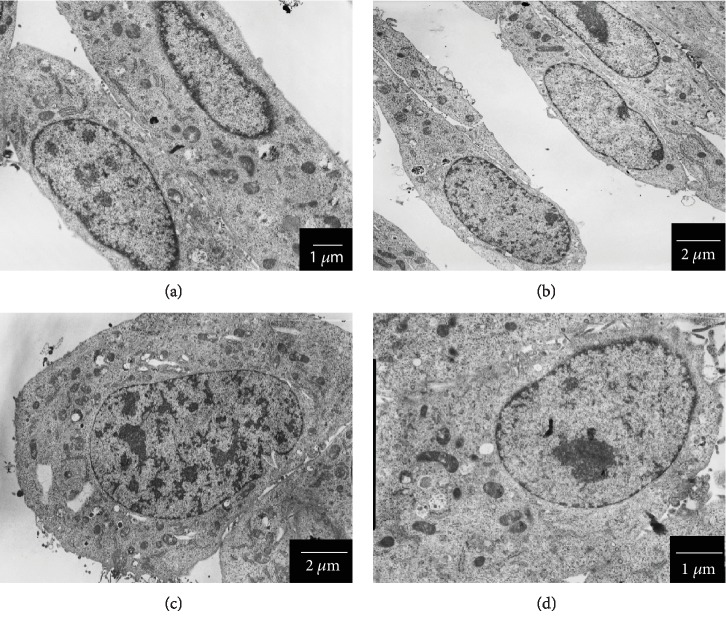
Morphology of C2C12 cells examined by TEM. (a) control cells, (b) cells treated with c-SOMPs (3 μg/mL), (c) cells treated with s-SOMPs (3 μg/mL), and (d) cells treated with b-SOMPs (3 μg/mL). Scale bar is present on the bottom right side of each picture.